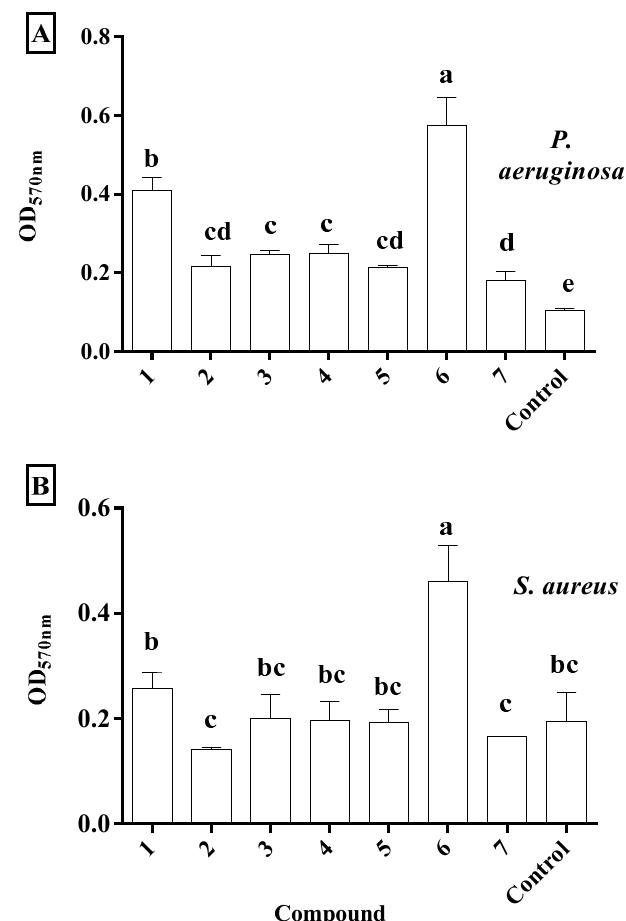
Figure 4. Biofilm formation (OD 570nm ) in the presence of 100 μ g of 3,4 ′ ,5,7-tetrahydroxyflavanone (1), 3 ′ ,4 ′ ,5,7-tetrahydroxyflavanone (2), 4 ′ ,5,7-trihydroxyflavanone (3), 3,4 ′ ,5-trihydroxy-7-methoxyflavanone (4), (+)-(2S)-4 ′ ,5,7-trihydroxy-6-methylflavanone (5), 4 ′ ,5,7-trihydroxy-6,8-dimethylflavanone (6), and 4 ′ ,5-dihydroxy-7-methoxyflavanone (7).